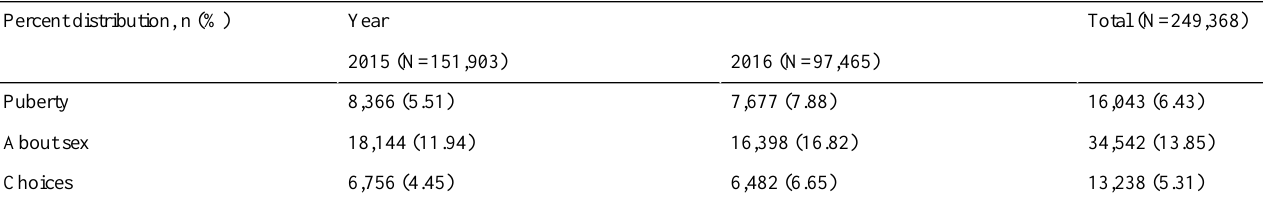
Table 7. Percent distribution of information requested on youth content among unique users.